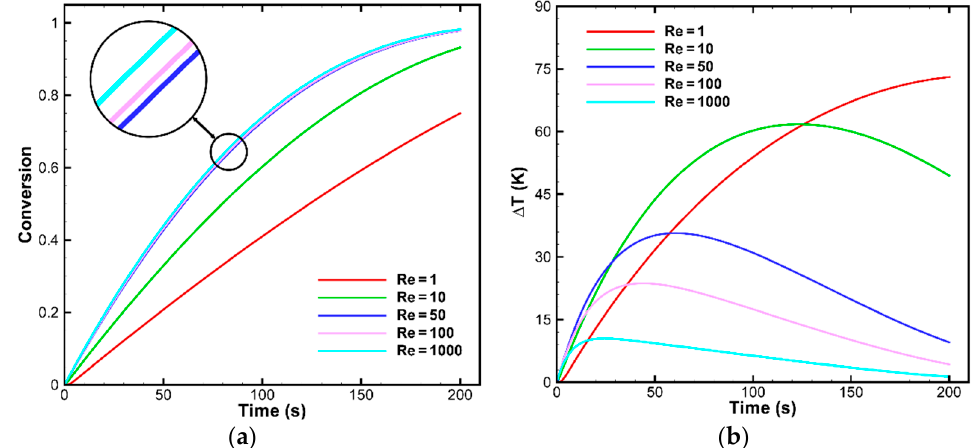
Figure 3. The profiles of ( a ) overall conversion and ( b ) ∆ T at various Reynolds numbers over time.